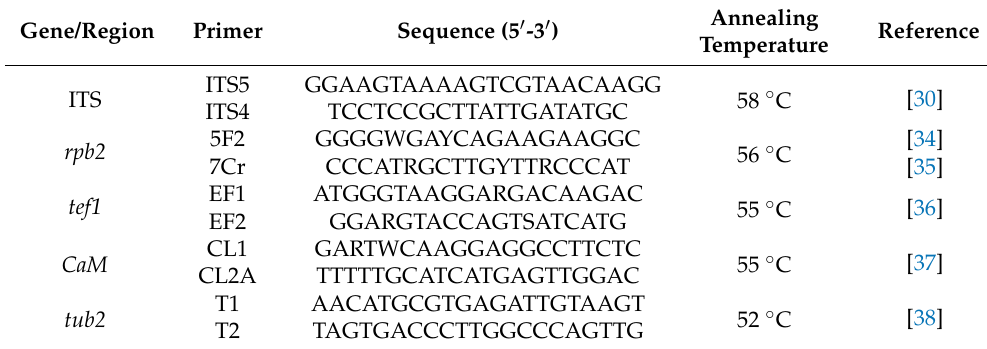
Table 5. Primers used in this